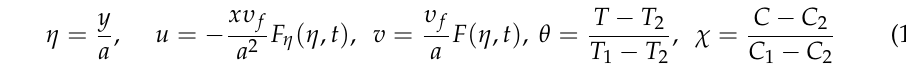
Figure 1. Physical model.